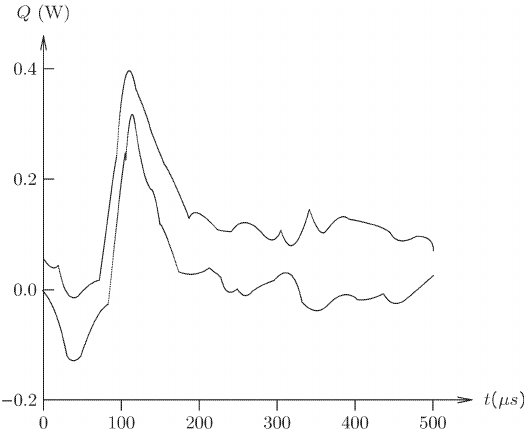
Figure 39. Upper and lower limits of stagnation point heat flux Q versus time.